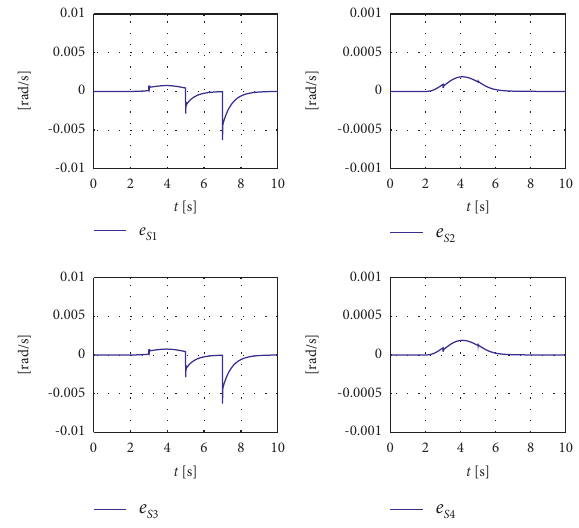
Figure 8: Angular velocity tracking errors obtained from the simulation results depicted in Figures 4–7 when abrupt variations are applied in parameters R and C of the DC/DC Buck converter- DC motor system and when E ( t ) emulates a renewable energy power supply given by equations (17) and